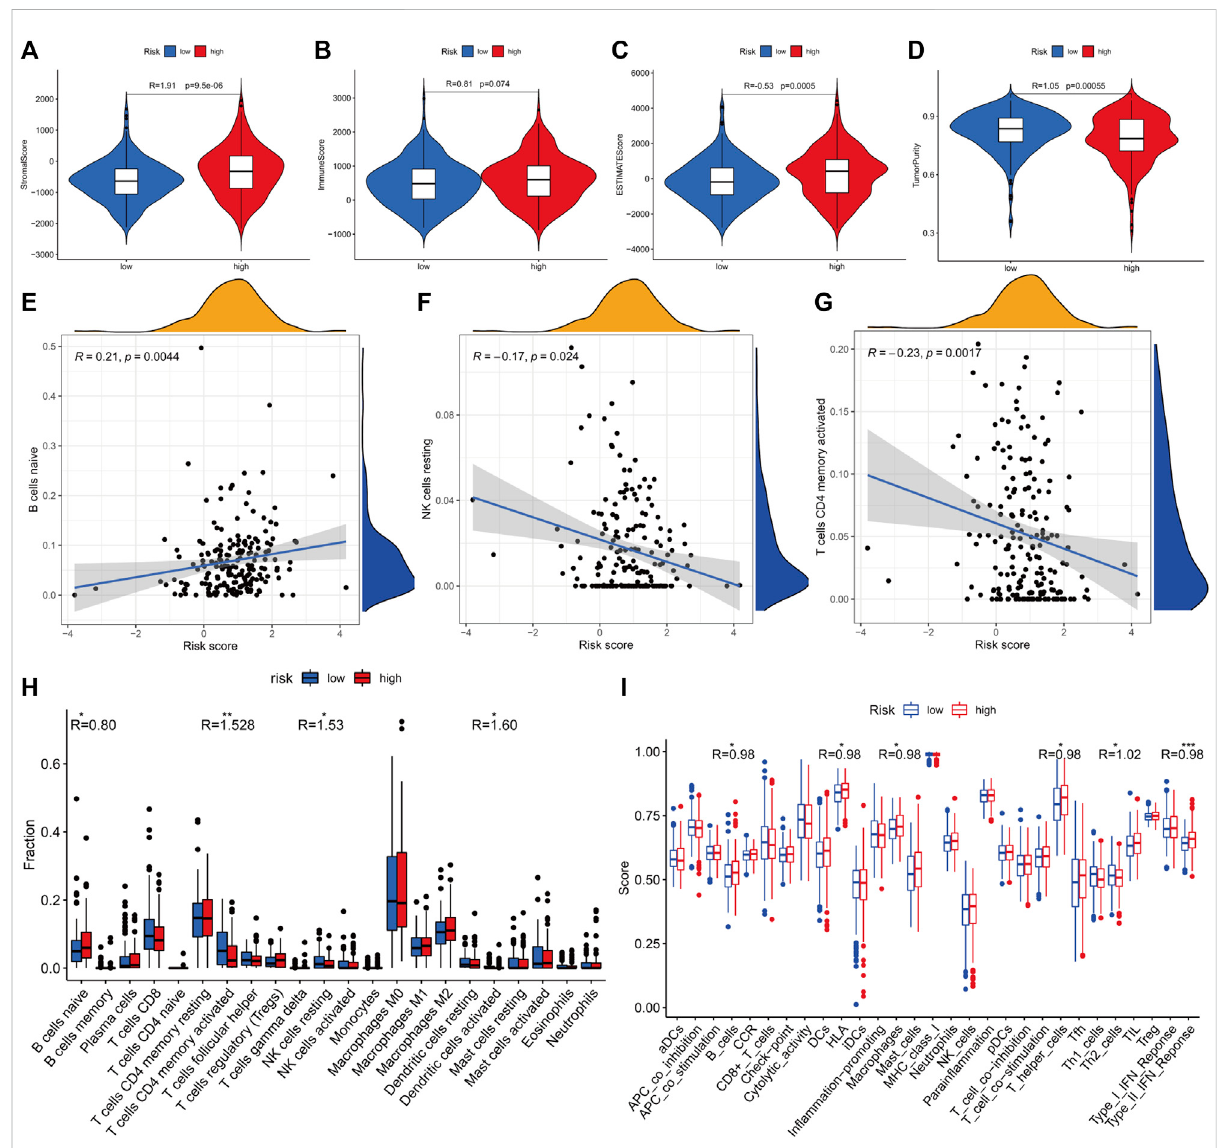
FIGURE 8 The landscape of tumor microenvironment. (A – D) Stromal, immune, and ESTIMATE scores and tumor purity in the two risk subgroups. (E – G) The correlation between the prognostic signature with naïve B cells, resting NK cells, and CD4 memory active T cells. (H) CIBERSORT analysis of immune cells. (I) ssGSEA scores of immune cells and activities ( p < 0.001, “ *** ” ; p < 0.01, “ ** ” ; p < 0.05, “ * ”